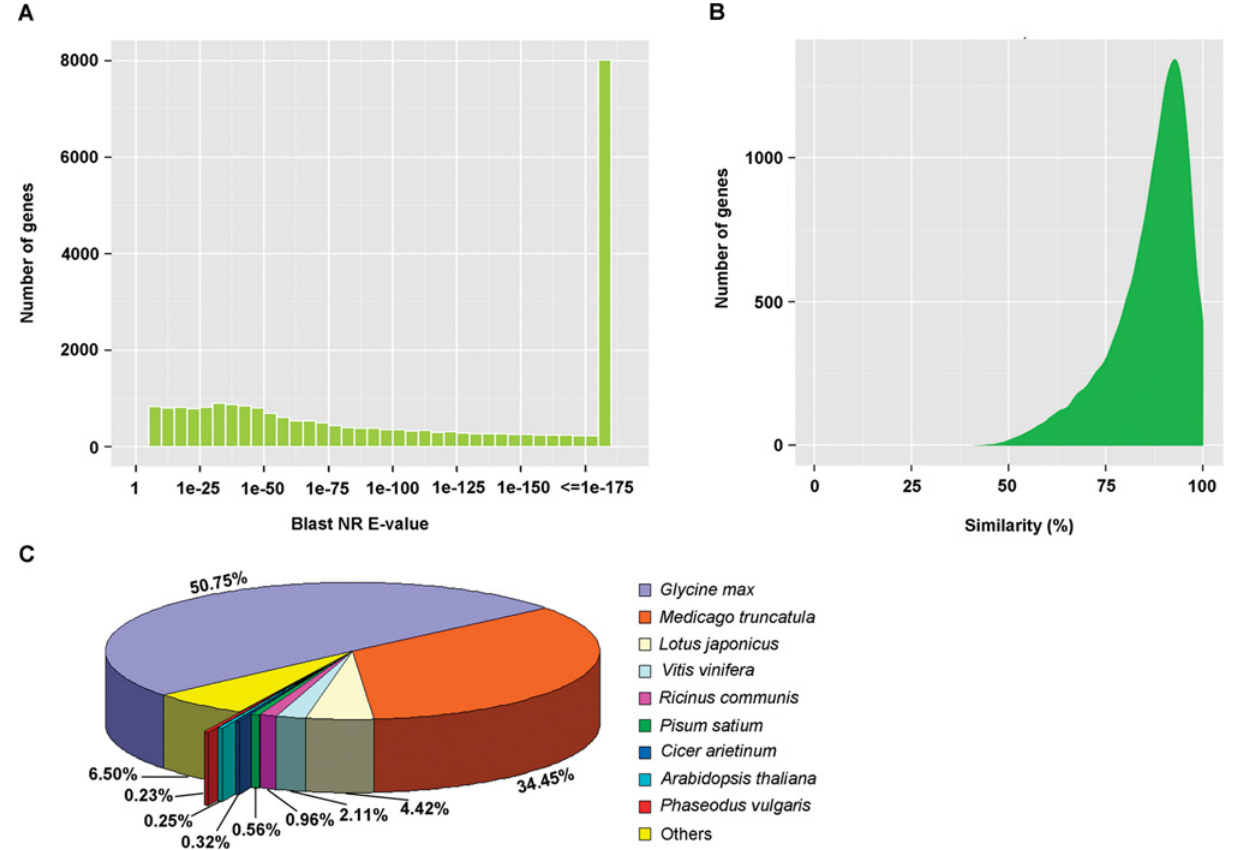
Fig 3. Characteristics of homology search of unigenes against the NR database. (A) E-value distribution of the top BLAST hits for each unigene with a cut-off E-value of 1.0E-5. (B) Similarity distribution of the best BLAST hits for each unigene. (C) Species distribution is shown as the percentage of the total homologous sequences with an E-value of at least 1.0E-5. We used all plant proteins in the NCBI NR database for homology search and extracted the first hit of each sequence for analysis.